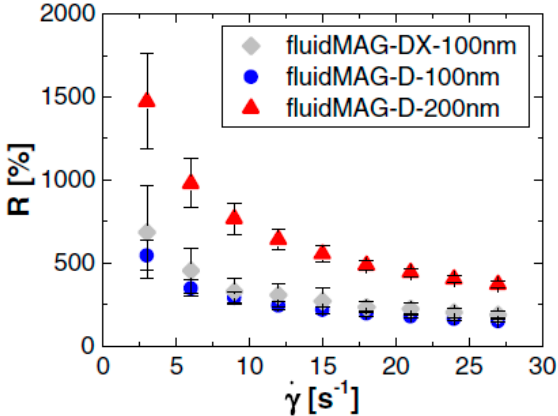
Figure 23. The shear rate dependence of the MVE of three ferrofluid samples at H = 30 kA / m. The commercial fluidMAG-DX-100 nm, investigated in previous studies [167,168], has multicore particles with hydrodynamic diameter 100 nm and stabilized with dextran. Reprinted with permission from Reference [164].